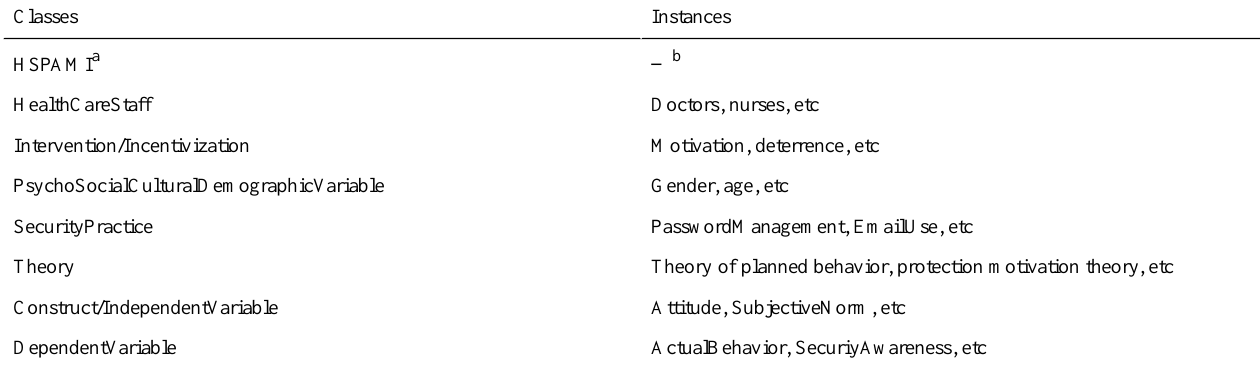
Table 5. Main concepts defined as classes.